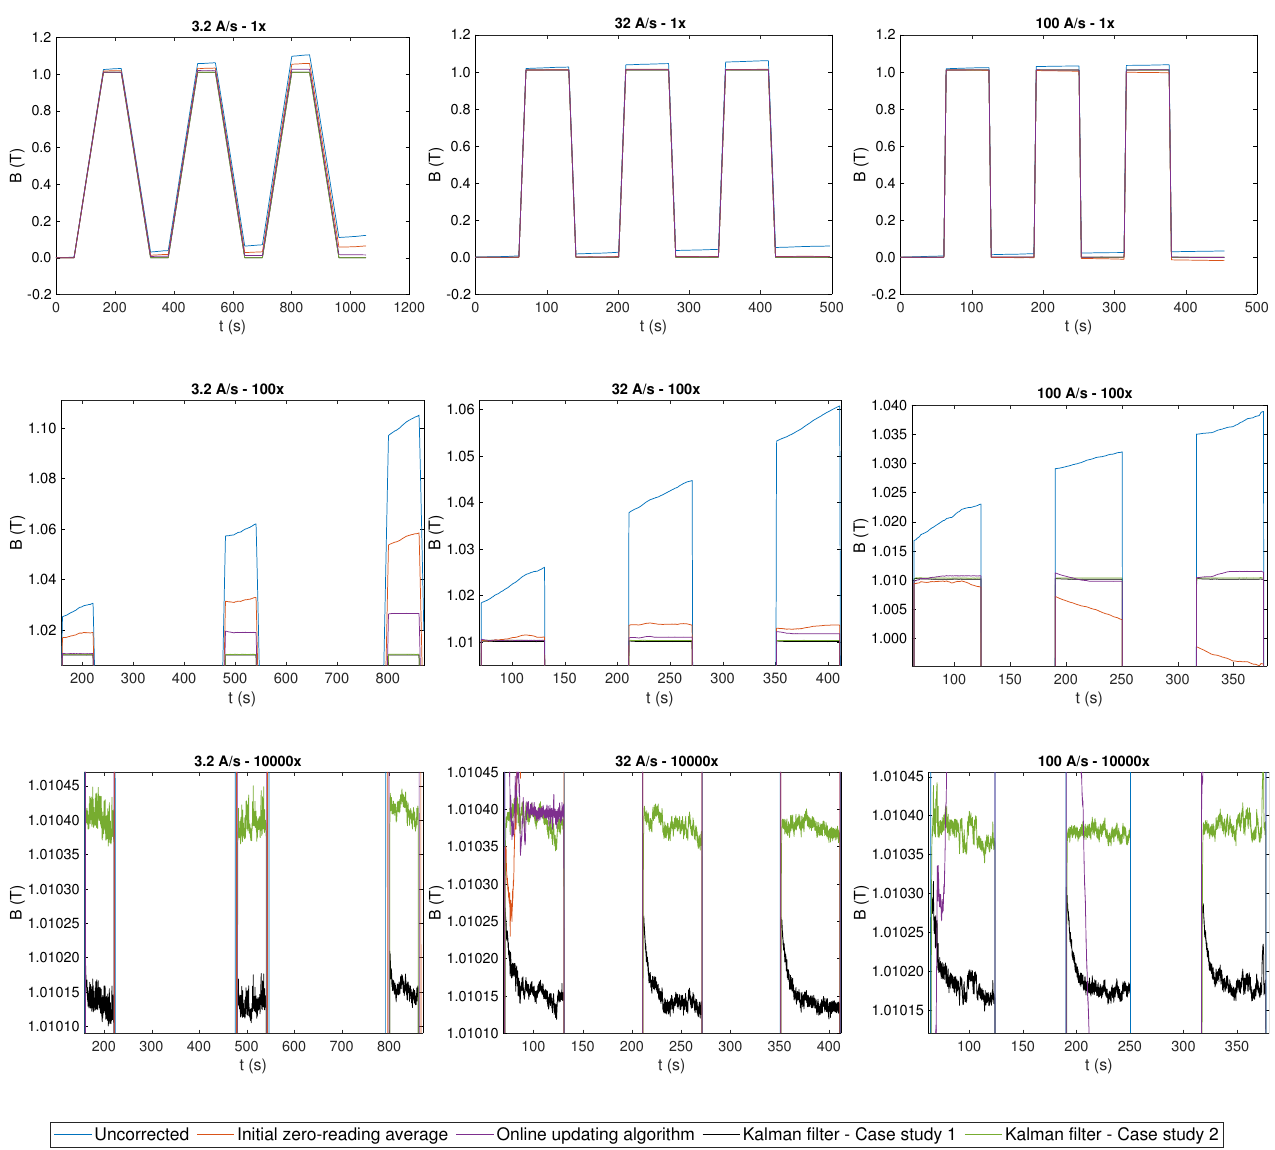
Figure 7. Magnetic field values obtained by Kalman filtering (black and green), when the field values measured by Hall probe are used in the measurement equation (case study 1), when the field values are estimated from the excitation current (case study 2), field values obtained by using the two feed-forward offset correction algorithms (orange and purple), and field values when no drift correction is applied (blue). From top to bottom: 1 × , 100 × , and 10,000 × magnification. From left to right: 3.2 A/s, 32 A/s, and 100